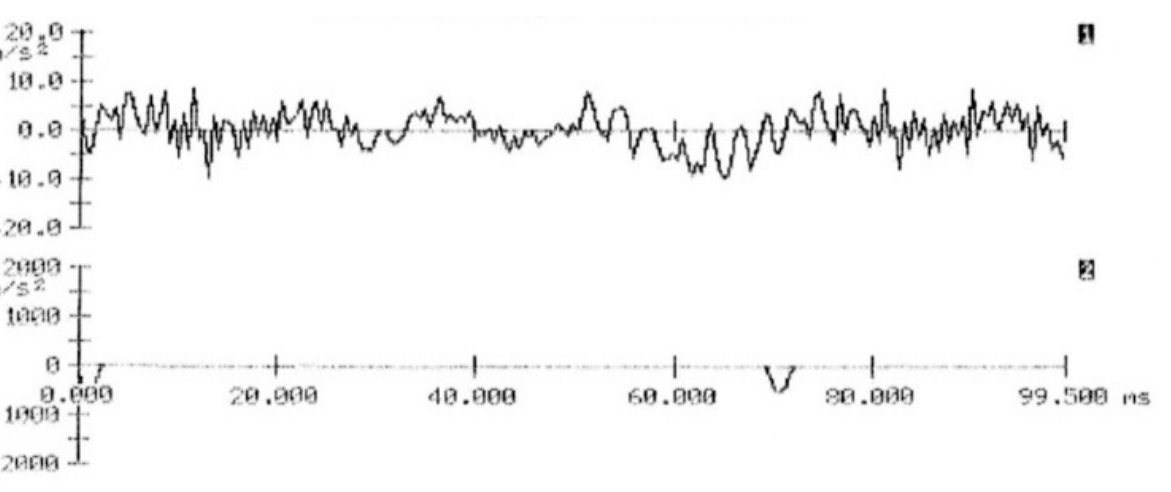
Figure 10. Synchronously averaged waveform of compressor torsional vibration acceleration: high pass filter—1 Hz; low pass filter—1 kHz; 16 averages.